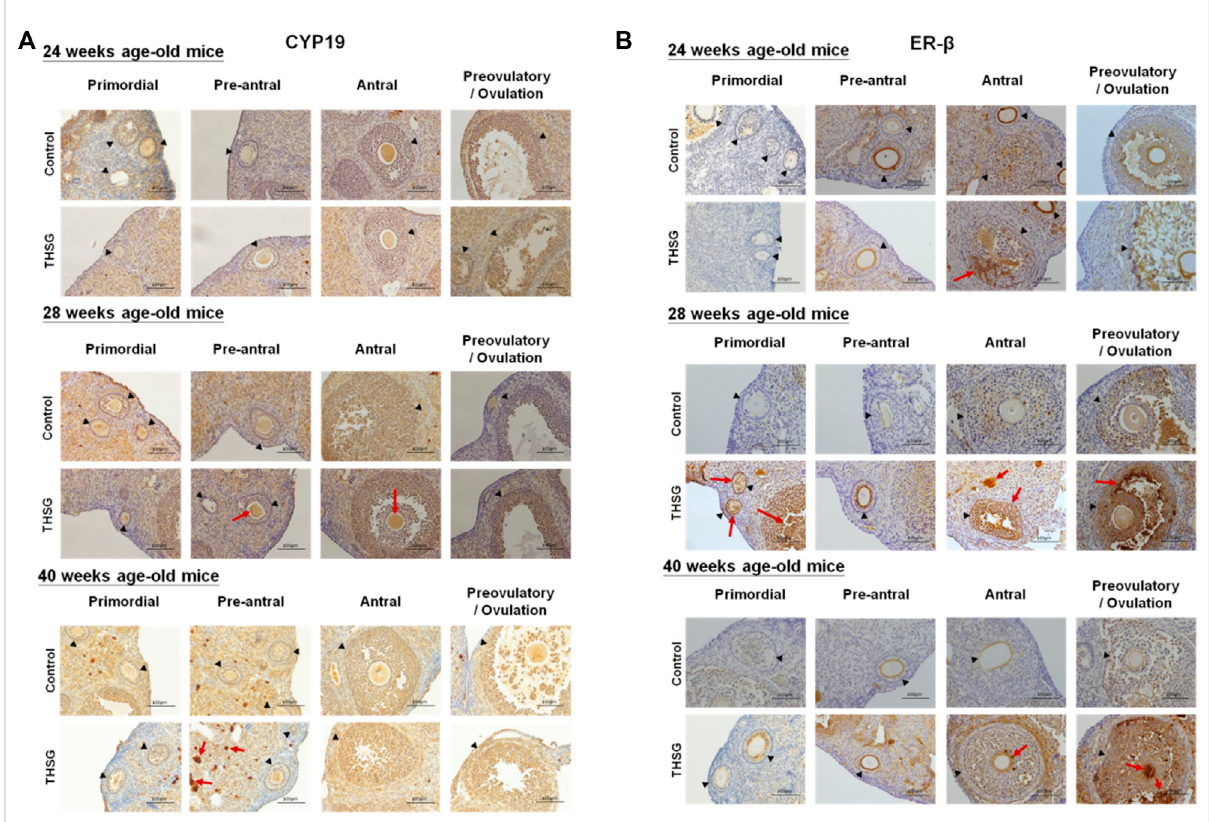
FIGURE 8 THSG affects protein levels of CYP19 and ER- β in different stages of folliculogenesis. Mice fed with THSG or untreated controls were sacri fi ced attheend of24, 28, and 40 weeksofage, and theovarieswerestained byIHCanalysis. (A) The black triangles indicate thefollicle formation, andthe redarrowsindicatethesigni fi cantCYP19accumulation(thebrownarea).Atdifferentstagesoffolliclematuration,CYP19accumulationwashigherin theTHSG-fedgroupthanintheuntreatedcontrolgroup.Asthemiceaged,CYP19accumulation remainedathigherlevelsintheTHSG-treated groupcomparedtotheuntreatedcontrolgroup. (B) Theblacktrianglesindicatethefollicleformation,andtheredarrowsindicatethesigni fi cantER- β accumulation (the brown area). In THSG-treated mice, ER- β accumulation, especially at the end of 40 weeks, was much higher than in controls.